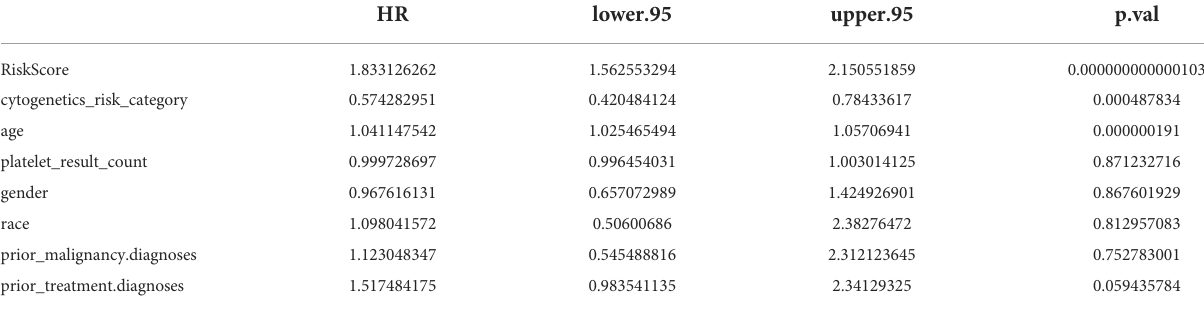
TABLE 3 Univariate Cox analysis in independent prognostic analysis.